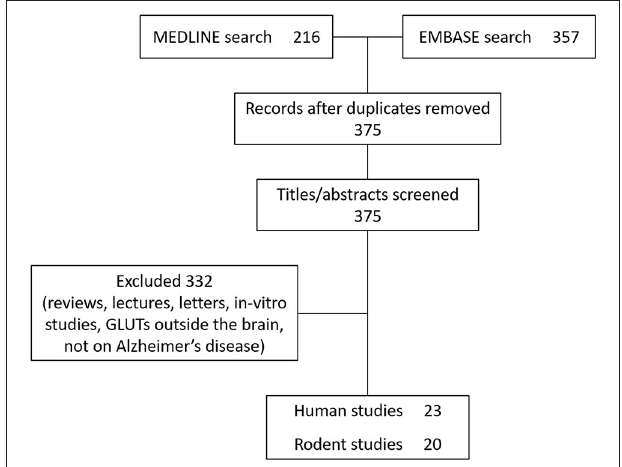
FIGURE 2 | PRISMA